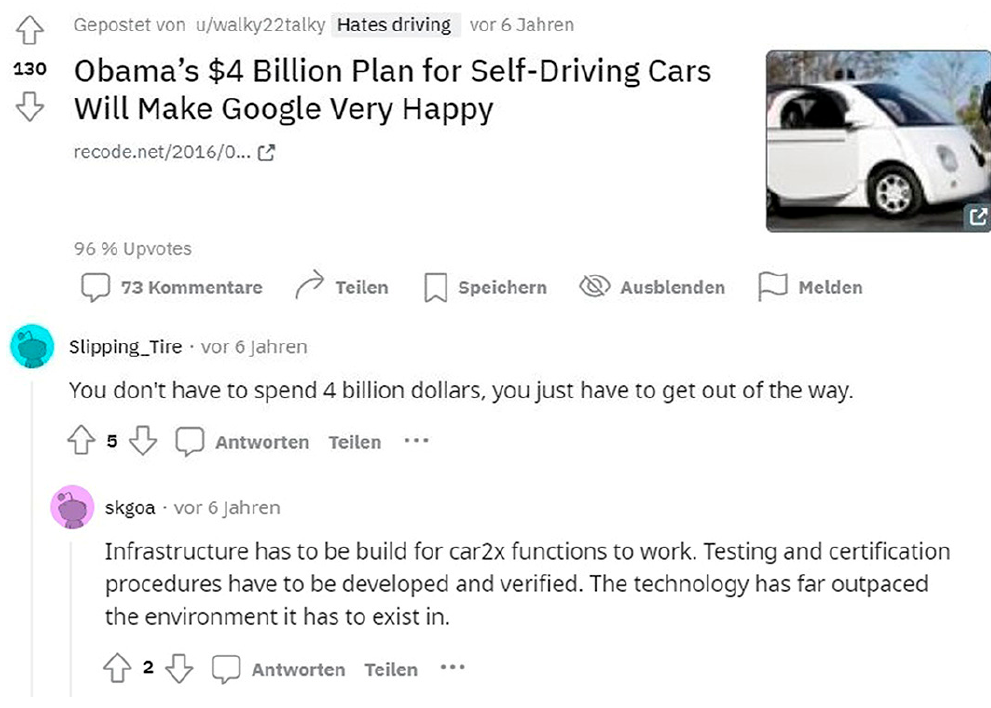
Figure 3. Statement about the necessity of V2X technologies for automated driving.